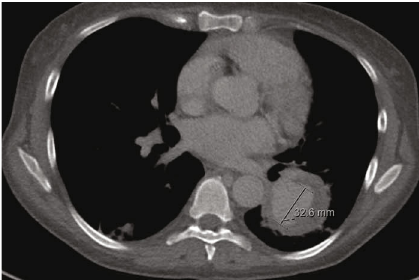
Figure 4: Axial computed tomography angiography depicting a pseudoaneurysm measuring 52 × 47 mm with an irregular central contrast collection measuring 32mm (marked above).